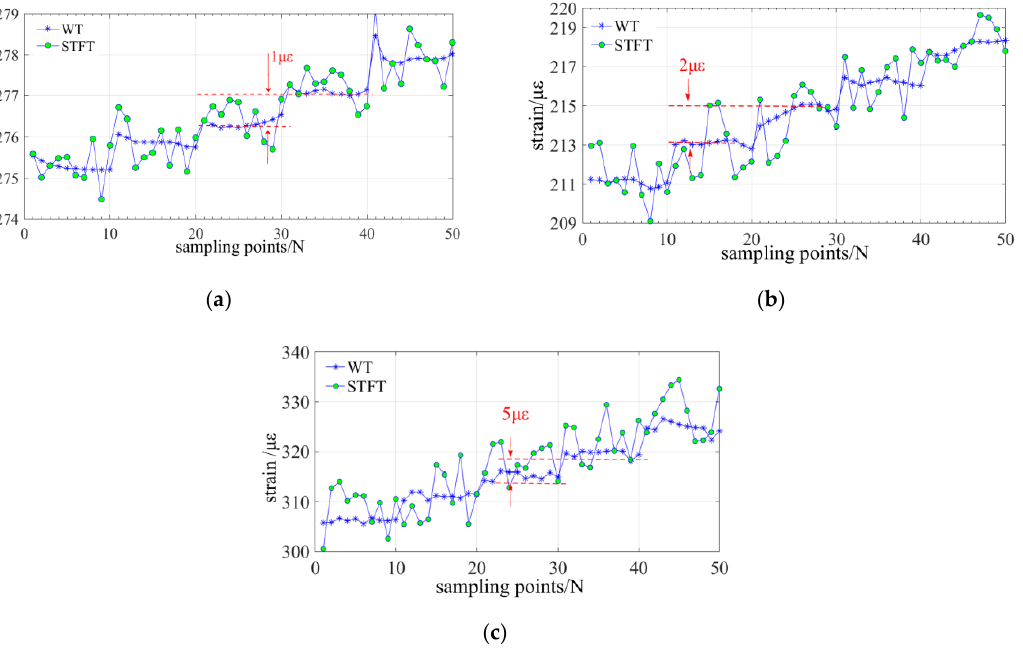
Figure 9. Experiment on the strain resolution under different spatial resolution: ( a ) spatial resolution is 20 mm; ( b ) spatial resolution is 8 mm; and, ( c ) spatial resolution is 5 mm.